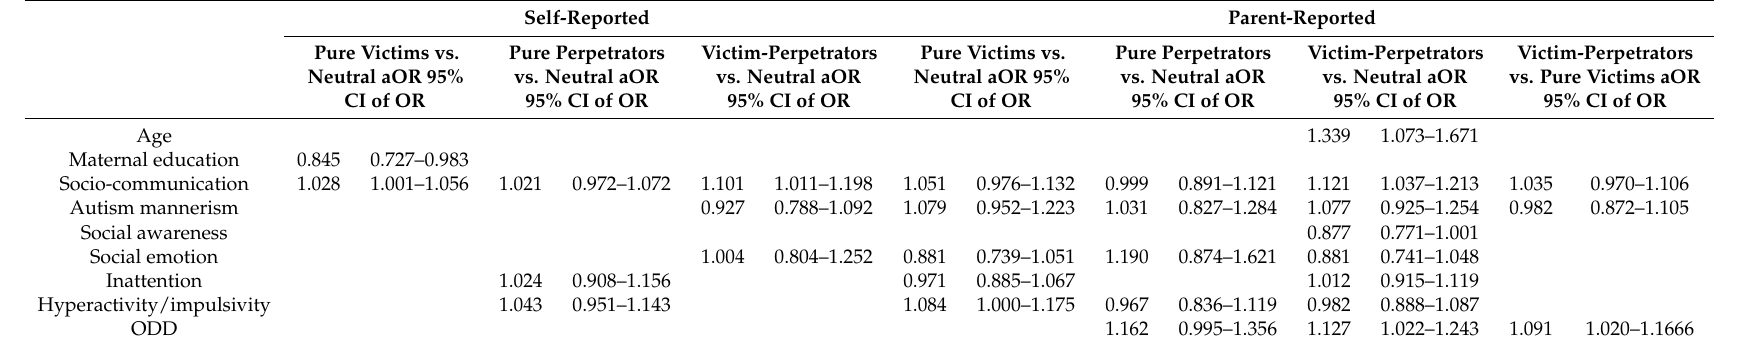
Table 5. The factors related to self-reported and parent-reported bullying involvement: logistic regression a